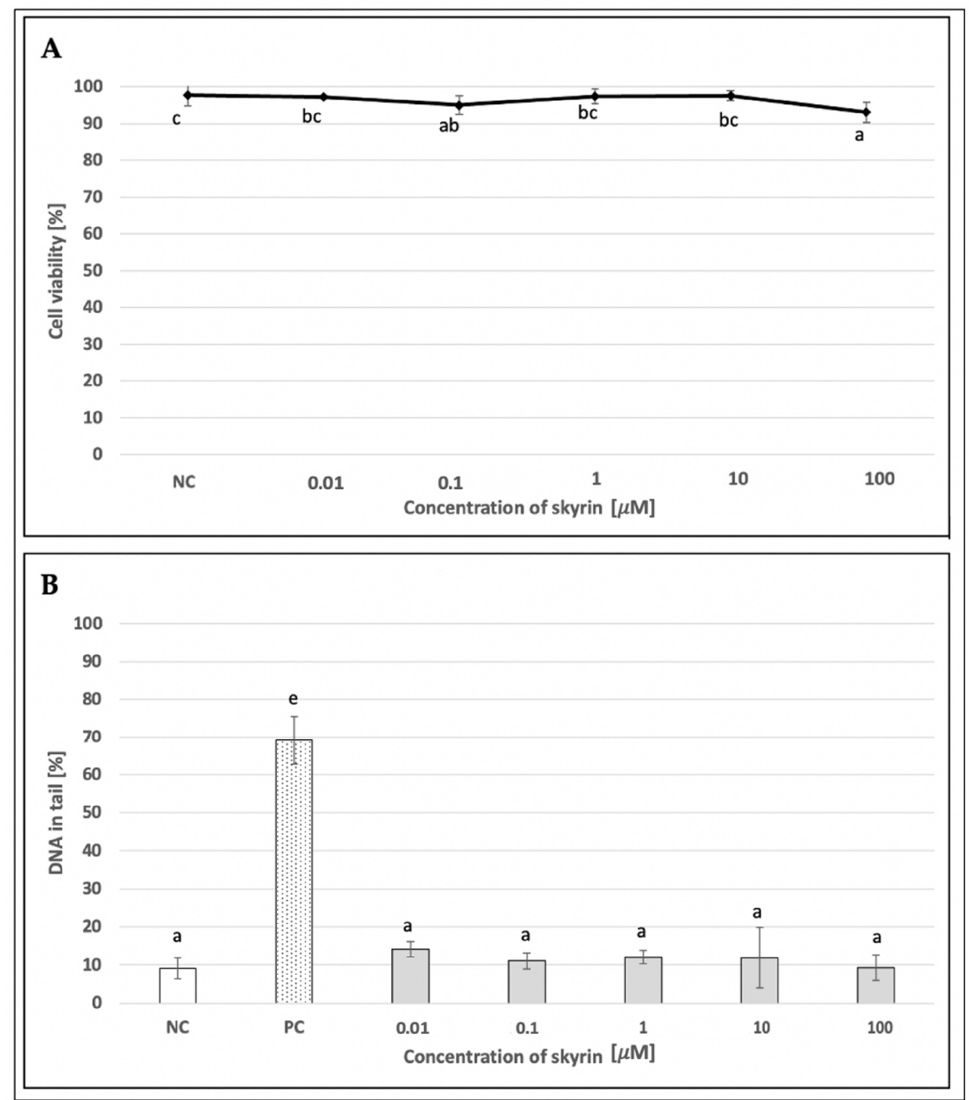
Figure 6. Evaluation of the potential cytotoxic ( A ) and genotoxic ( B ) effects of skyrin (SK) on human lymphocytes (1 h treatment) at different concentrations, using the trypan blue exclusion test and the comet assay. Negative control (NC)—untreated cells; positive control for comet assay (PC)—cells treated with 440 μ M hydrogen peroxide. Results were analyzed by ANOVA single-step multiple comparisons of means using LSD tests, and comparisons between the mean values were considered significant at p < 0.05. Similar letters represent samples with no statistically significant differences between them. All experimental data in this work are from at least three independent experiments.